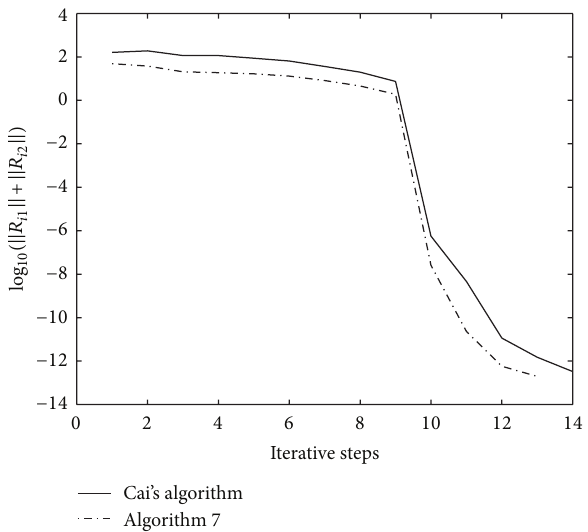
Figure 1: Convergence curves of log 10 (‖𝑅 𝑖1 ‖ + ‖𝑅 𝑖2 ‖)